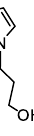
Figure 10. Complex 7 .